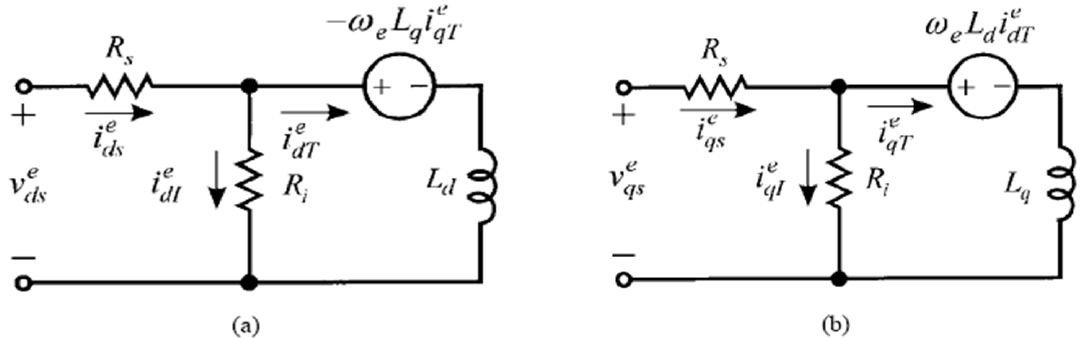
Figure 1. Biaxial equivalent circuit of a reluctance synchronous motor by considering iron losses: ( a ) axis d, ( b ) axis q adopted from [34].